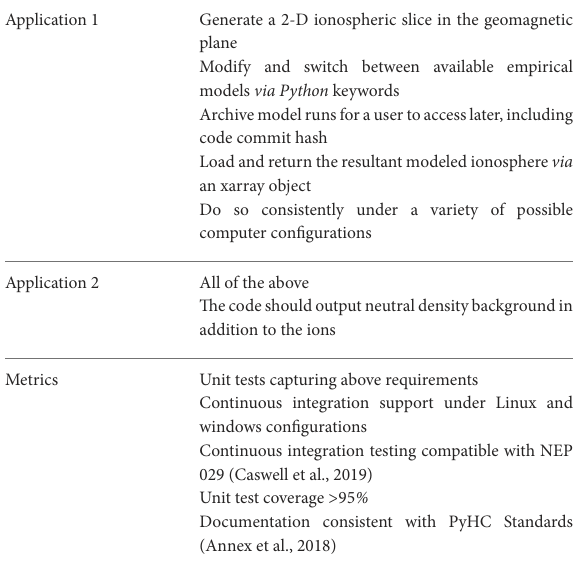
TABLE 5 Requirements and Metrics for the sami2py